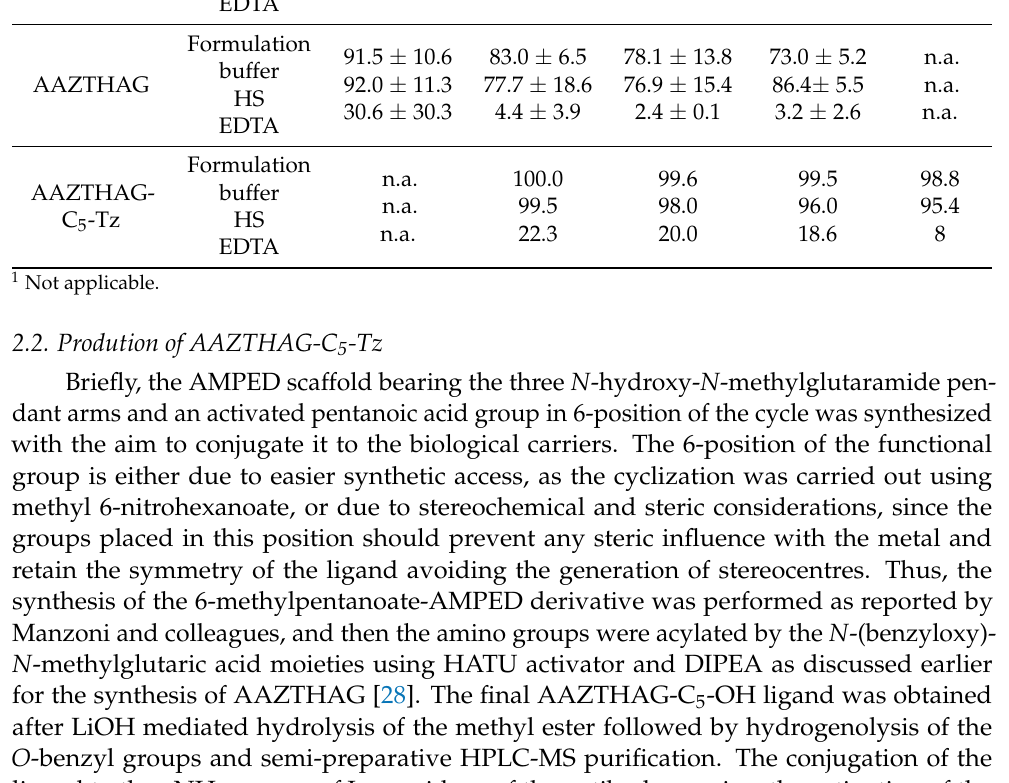
the origin (Rf = 0.0). Data are expressed as % of 89 Zr complexed over total activity measured ( 89 Zr